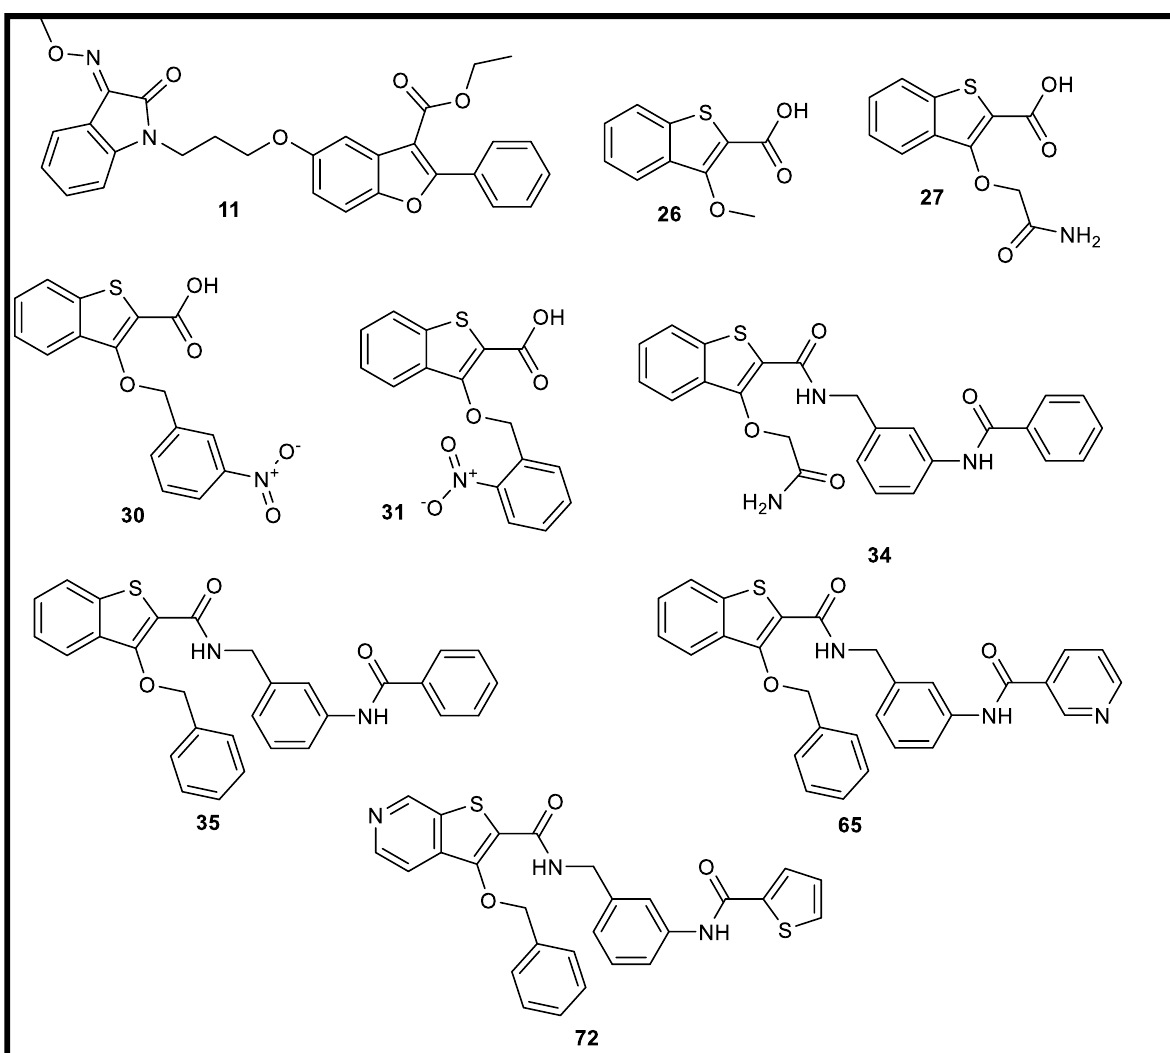
Figure 3. Compounds 11, 26, 27, 30, 31, 34, 35, 65, and 72 exhibited medium to very low BBB penetration levels. Table 2. Predicted computational ADMET for the tested candidate.